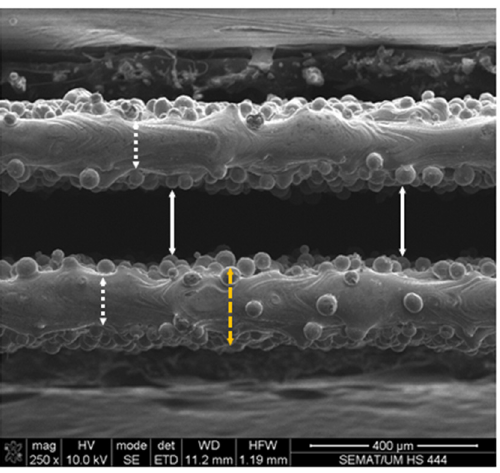
Figure 4. Measurements performed on the Ti6Al4V thin-walled tubes.